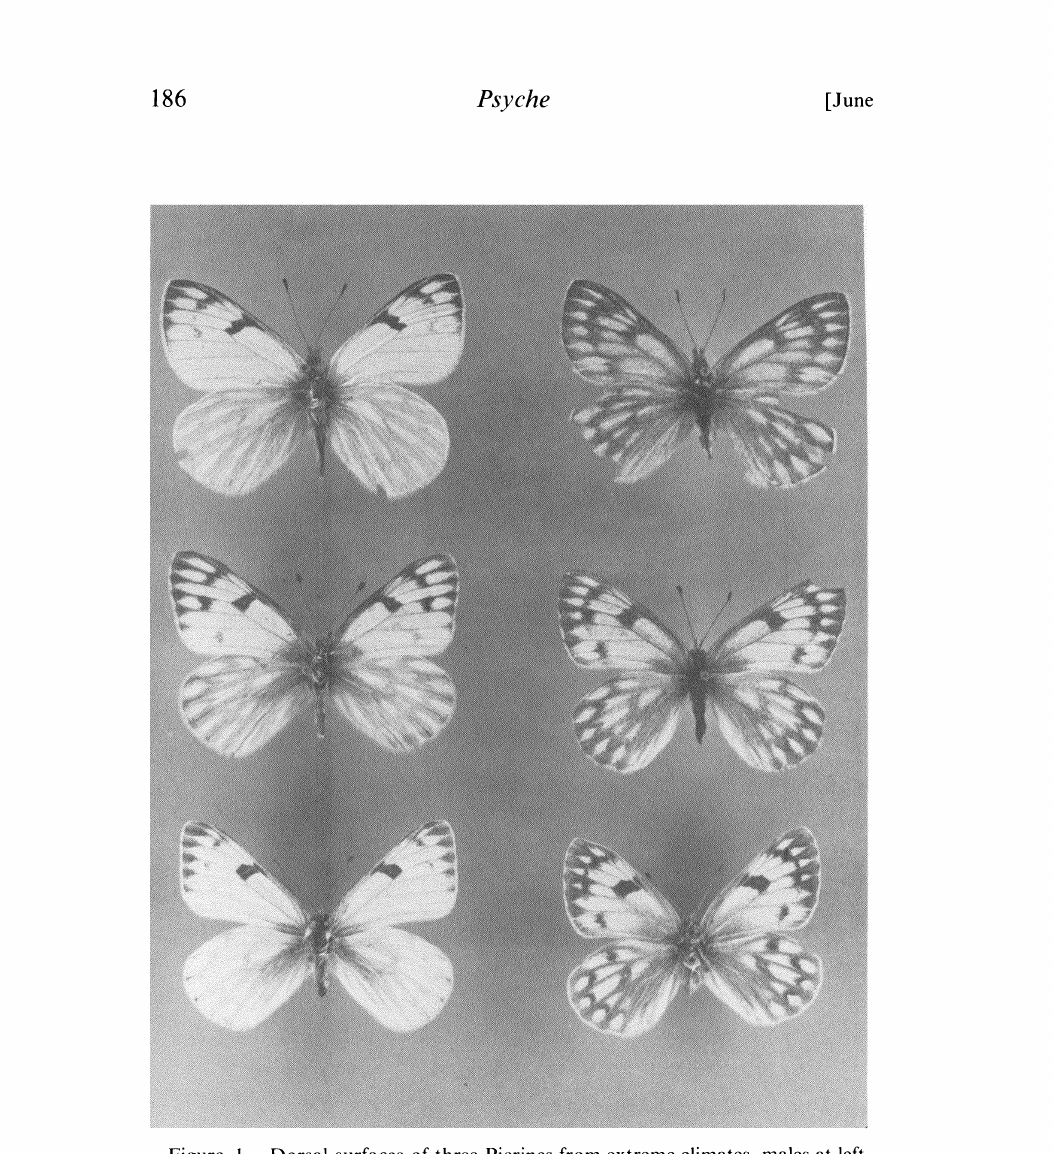
Figure I. Dorsal surfaces of three Pierines from extreme climates, males at left. Top row: Reliquia santarnarta, 4200 m,-Sierra Nevada de Santa Marta, Colombia, 1044 N. Centre: Pieris occidentalis "cal.vce,’" 3640 m, Colorado front range, USA, 4001 N. Bottom: Pieris occidentalis nelsoni, Fairbanks, Alaska, 6451